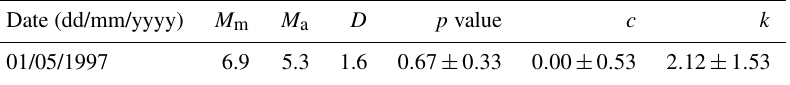
Table 3. Aftershocks characteristics of 1 May 1997 event. Date (dd/mm/yyyy)